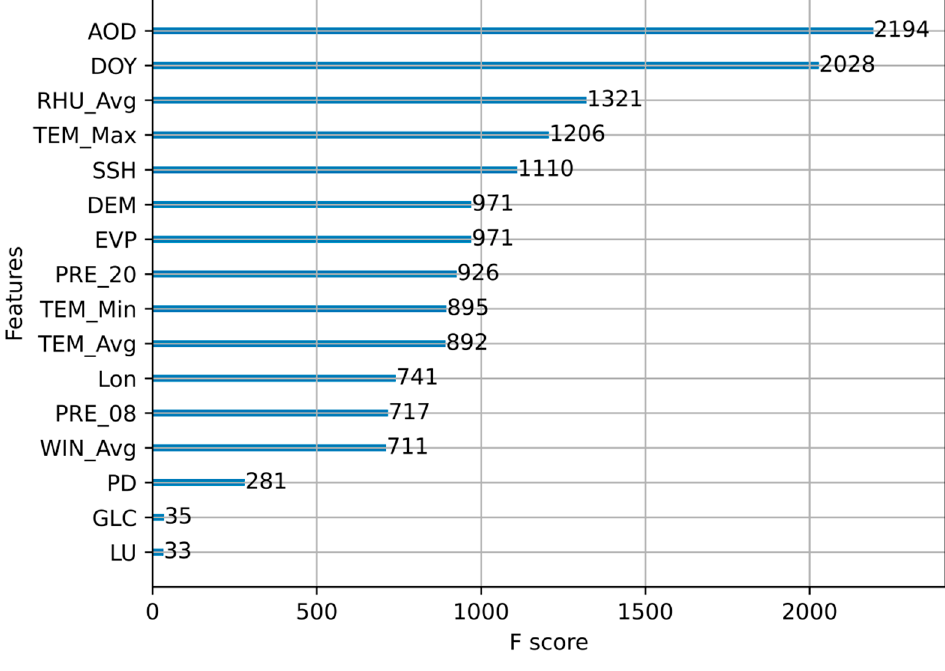
Figure 3. Feature importance for the XGBoost model.